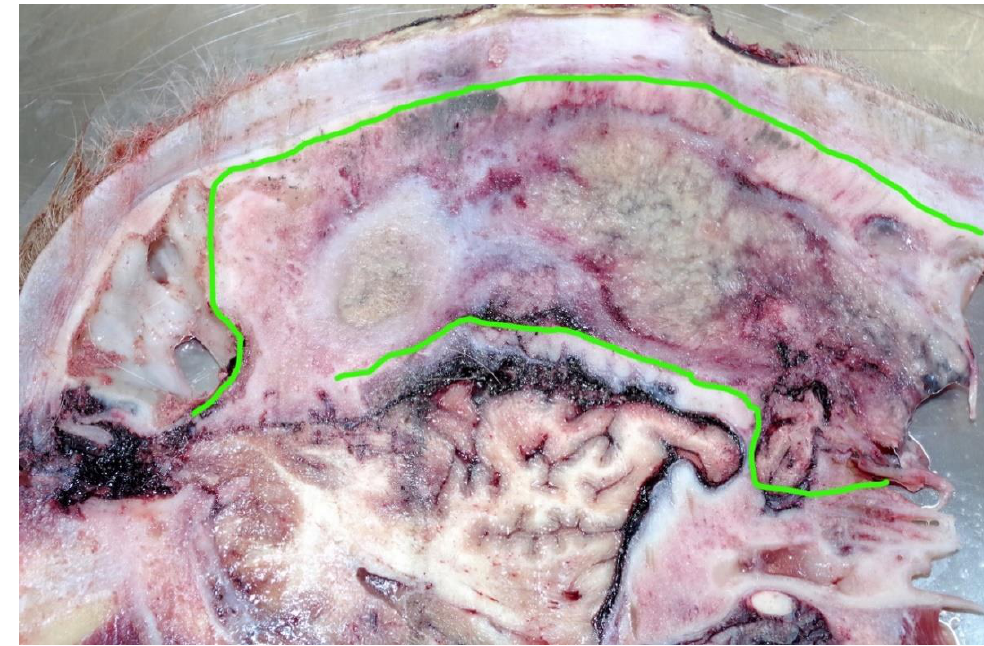
Figure 8. A head slice taken from 1.5 cm lateral to the midline. The left sagittal section showing chronic fibrous sinusitis with pus formation highlighted in green .